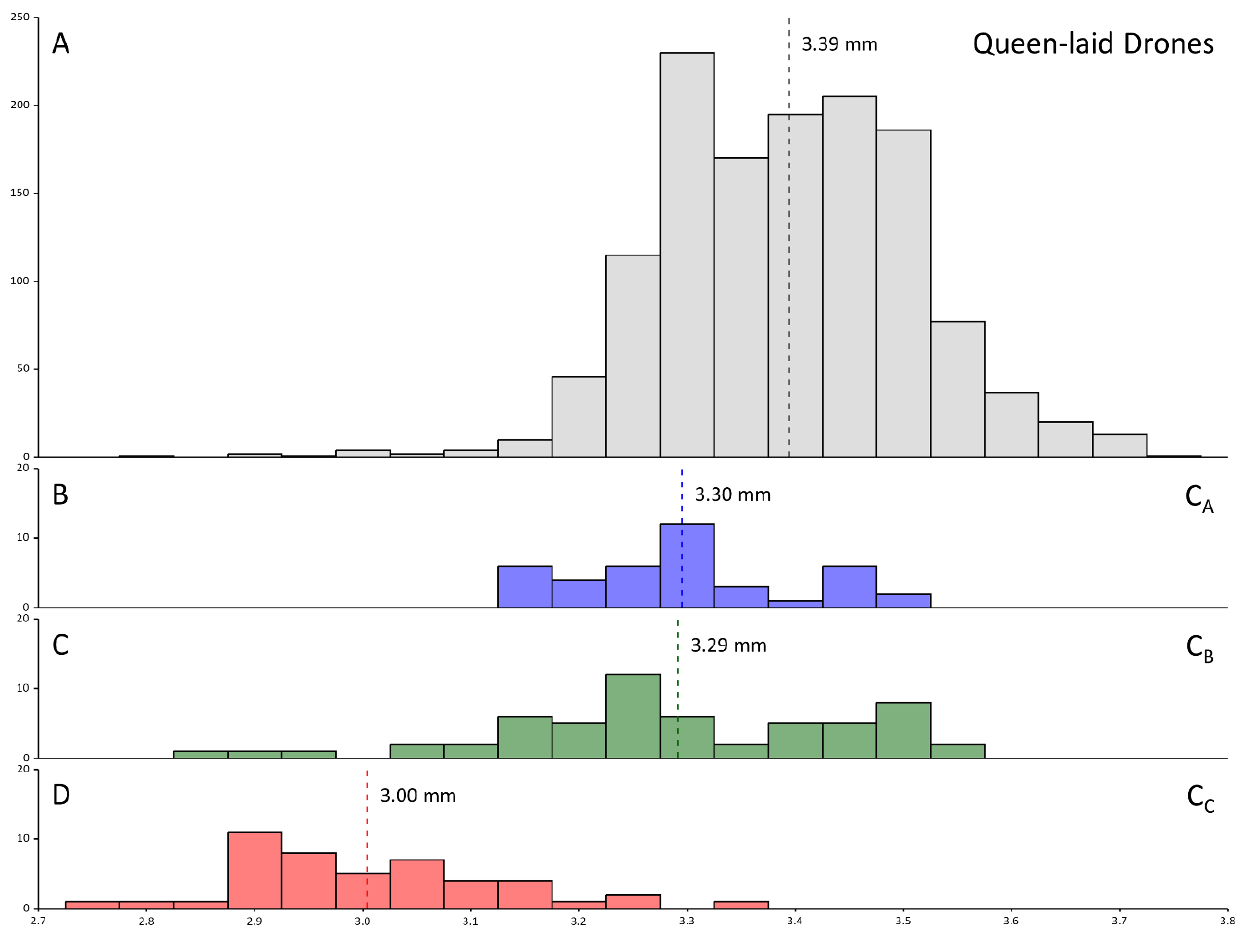
Figure 2. Histograms of the head width of drones used in this study. Dashed lines indicate the mean of each distribution. ( A )—The head size distribution of all drones from queenright colonies in this study whose genotype indicated they were sons of the queen. ( B , C )—The head size distribution of drones from colony C A and C B , respectively. The mean head size is >3.2 mm, indicating that workers are not reproducing in this colony. ( D )—The head size distribution of drones from colony C C . The mean head size is <3.2 mm, indicating that workers are reproducing in this colony.